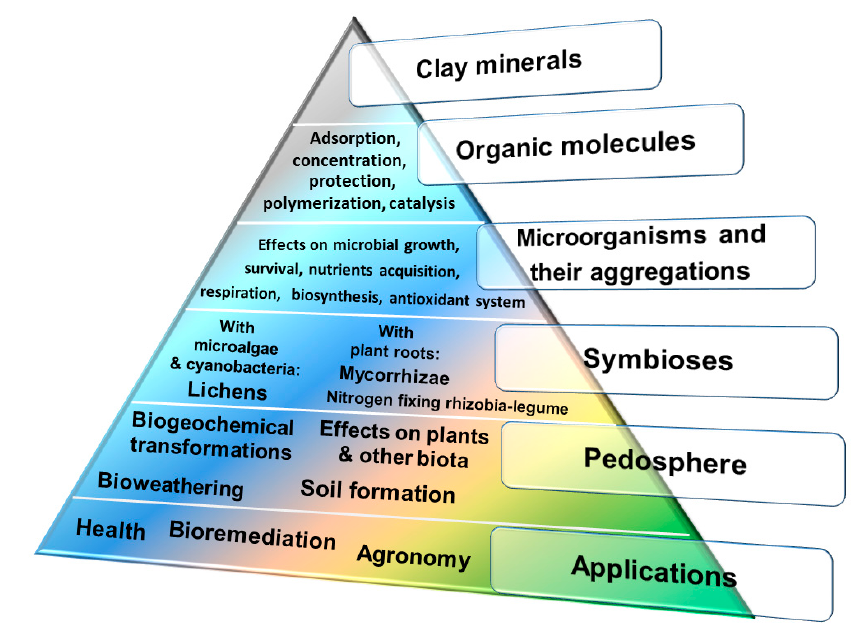
Figure 7. Some important aspects of the interactions of clay minerals with microorganisms at different levels of complexity: organic molecules, individual microbial cells and their aggregates (e.g., biofilms), fungal and bacterial symbioses with photosynthetic organisms, pedosphere; and their environmental and biotechnological implications.